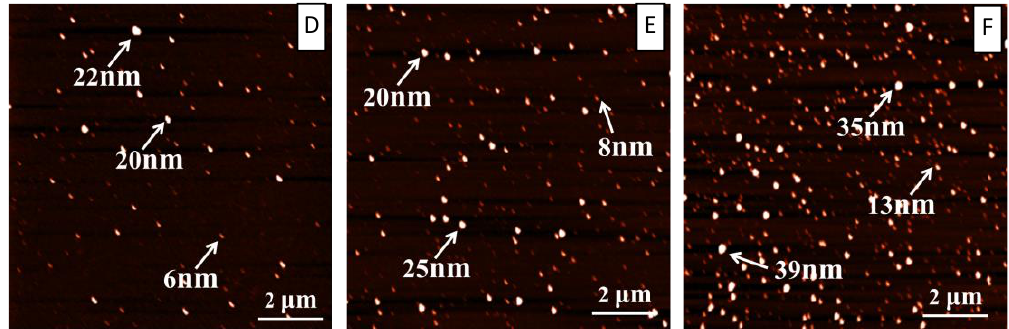
Figure 3. Atomic force microscopy (AFM) characterizations of lysozyme fibrillation under the influence of different concentrations of tannic acid at t = 0 h during incubation. ( A ) Control; ( B ) 150 µ M;